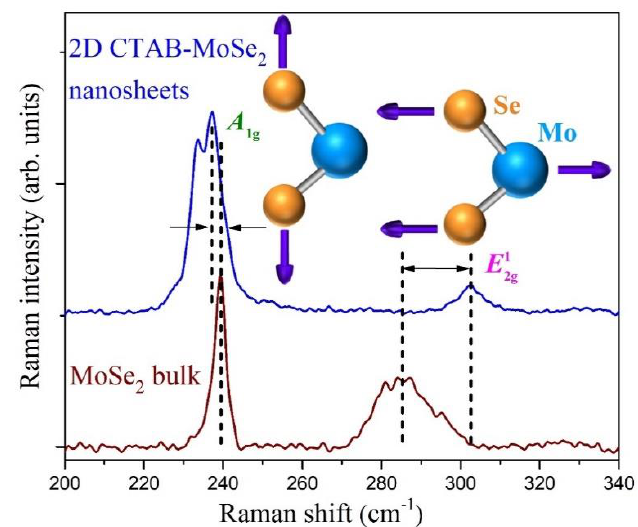
Figure 7. Raman spectra of the source MoSe 2 bulk powder (brown line) and as-produced 2D CTAB-MoSe 2 nanosheets (blue line). The Raman shifts are denoted by the dashed lines. The inset sketch depicts the atomic displacements of the two vibrational modes leading to the primary Raman peaks.